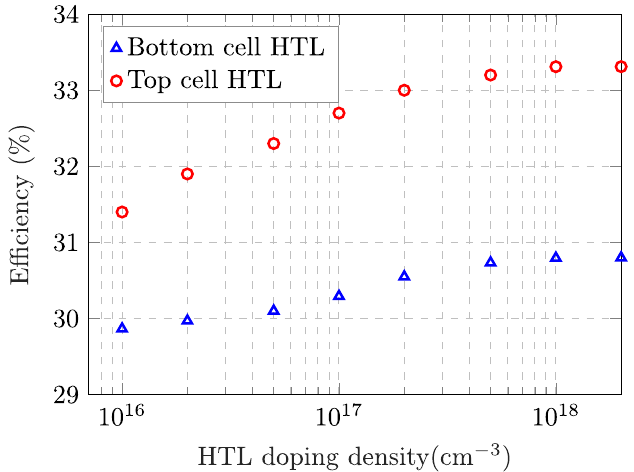
Fig. 13. Calculated tandem ef fi ciency with doping in top and bottom cell hole transport layers. Initially, the top cell doping is fi xed at 1 (cid:4) 10 18 cm (cid:2) 3 , and the bottom cell ef fi ciency is increased upto 1 (cid:4) 10 18 cm (cid:2) 3 . Then, the bottom cell HTL doping is fi xed at 1 (cid:4) 10 18 cm (cid:2) 3 , and the top cell HTL is doping is varied upto 1 (cid:4) 10 18 cm (cid:2) 3 . The top and bottom cell bandgaps are chosen to be 1.55 eV and 1.0eV, respectively. The top and bottom cell thicknesses are fi xed at 250 nm and 350 nm,